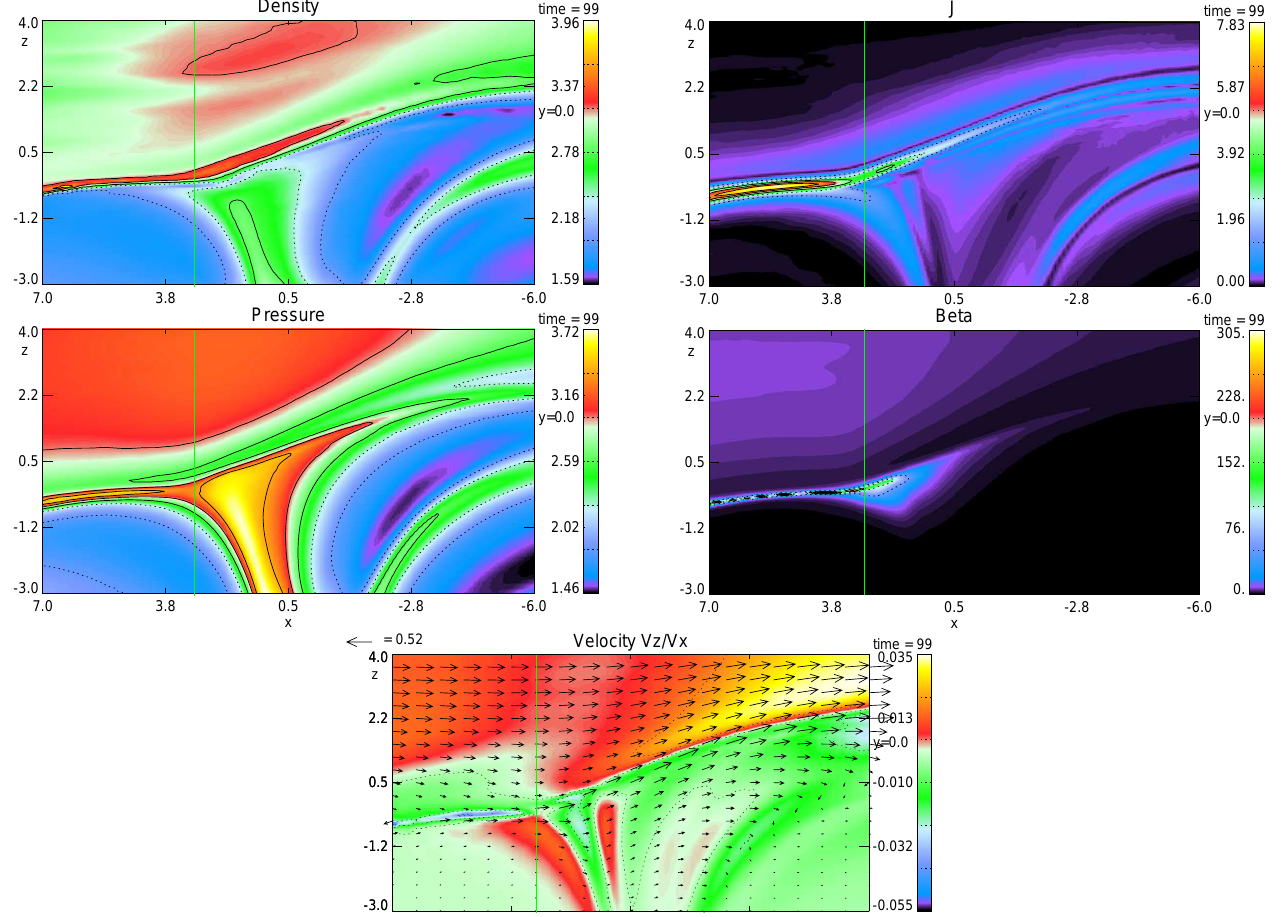
Fig. 10. From top to bottom, the plots on the left display plasma density, thermal pressure, and plasma velocity, while those on the right display current density ( J ) and plasma β . All parameters are shown in the noon-midnight meridian plane. The green vertical lines indicate the trajectories along which simulated data is analyzed.